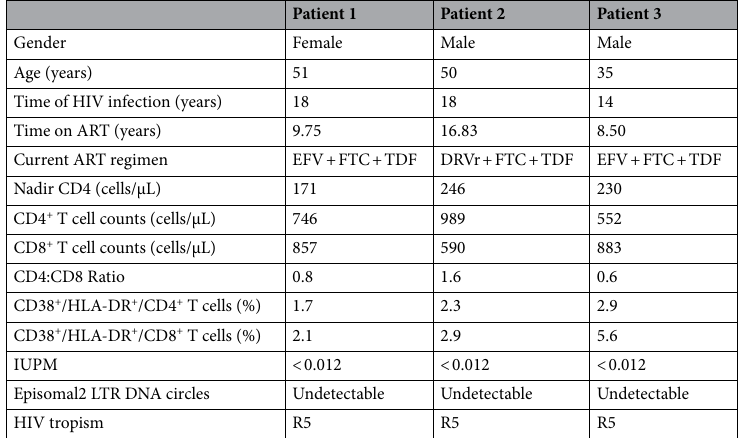
Table 1. Socio-demographic and clinical characteristics of the study patients at the time of starting the analytical treatment interruption. ART antiretroviral treatment, DRVr ritonavir-boosted darunavir, EFV efavirenz, FTC emtricitabine, TDF tenofovir, IUPM infections units per million